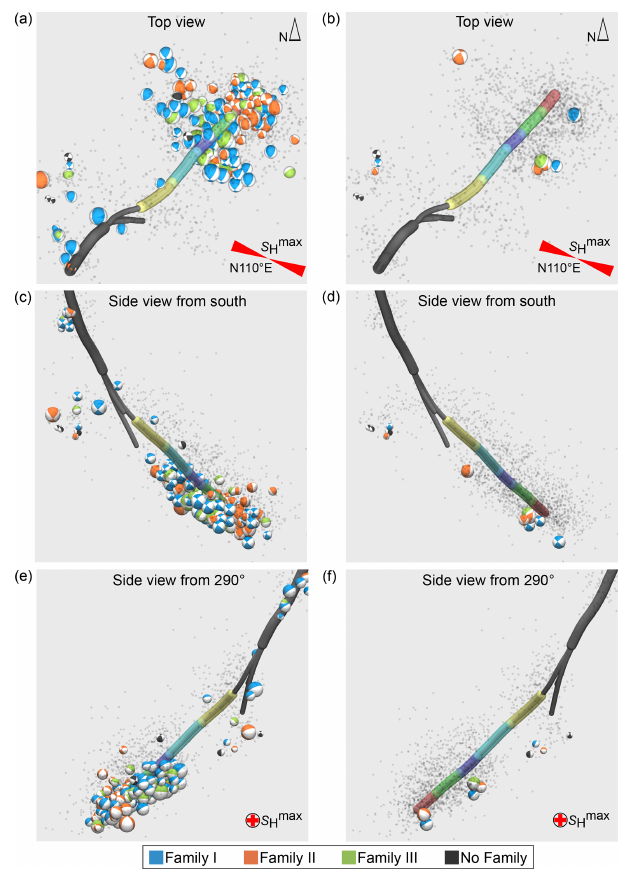
Figure 7. Orthogonal views of estimated focal mechanisms in three different projections: (a, b) map view, (c, d) side view from the south (180 ◦ ), and (e, f) side view from the NW (290 ◦ ) along the di- = 110 ◦ . (a, c, e) All rection of the maximum horizontal stress S max H 191 estimated focal mechanisms. (b, d, f) Focal mechanisms of post-stimulation events. The color code indicates the family ob- tained. Relocated seismicity without estimated focal mechanisms is plotted as small grey